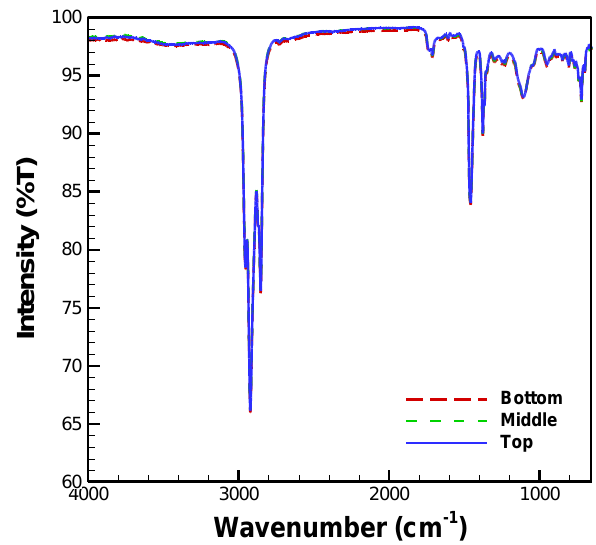
Figure 7. FTIR spectra of the emulsion with 2 g bio-oil and B/E = 1 under 100 °C at 7 days.